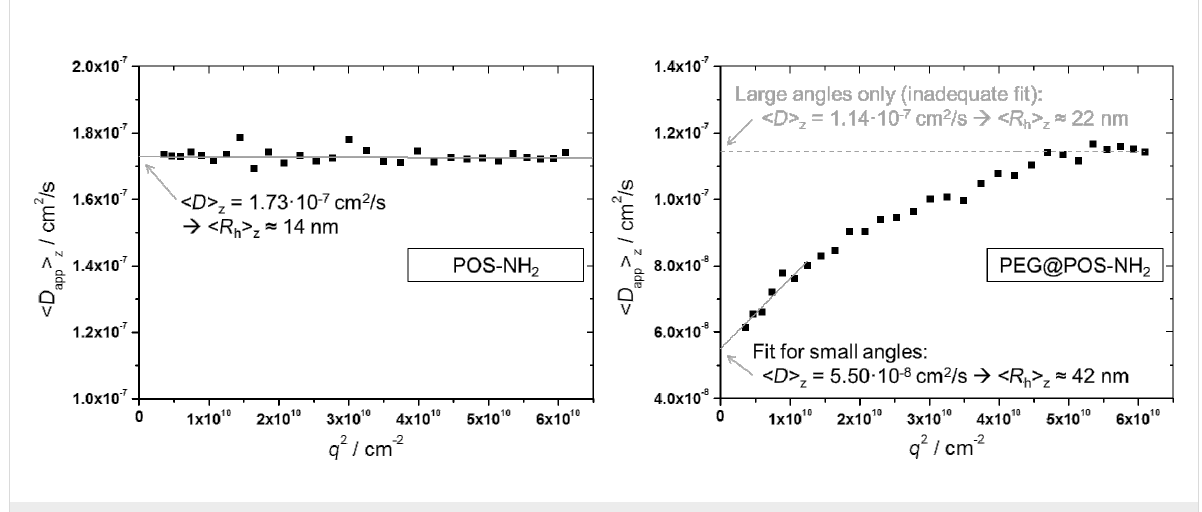
Figure 2: Apparent self-diffusion coefficients ( D s,app ) from angular-dependent DLS measurements with respect to the squared scattering vector ( q 2 ) for the samples POS-NH 2 and PEG@POS-NH 2 . In contrast to POS-NH 2 , the sample PEG@POS-NH 2 shows an angular dependence of the D s,app values and a linear fit of only the large scattering angles ( θ < 120°) would disregard a second fraction of larger particles. This is a clear indication of agglomeration and an explanation for the large polydispersity value of this sample. Furthermore, this example nicely illustrates that especially for poly- disperse samples only the extrapolation q 2 → 0 can yield true values for D s (and similarly also for R h